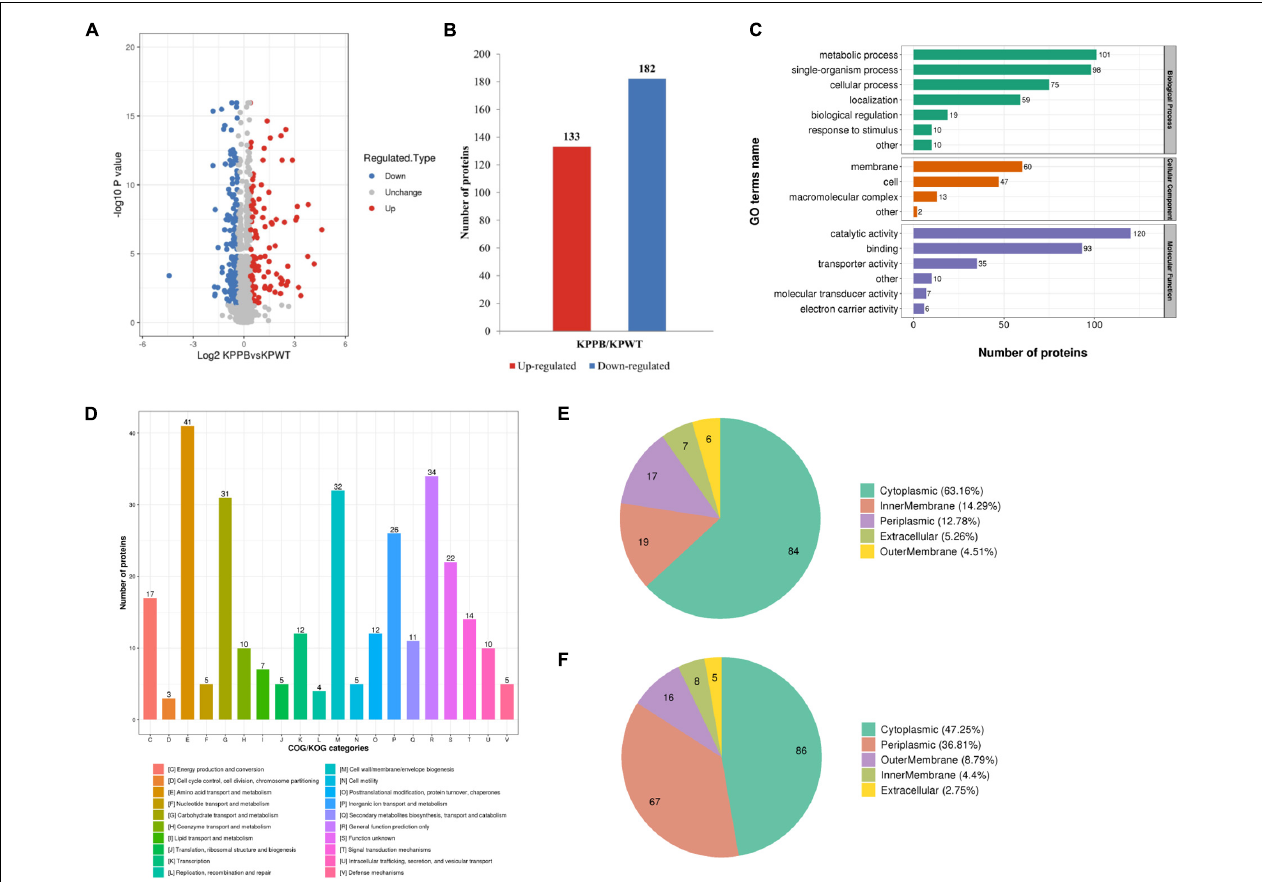
FIGURE 2 | Quantitative proteomics analysis of polymyxin B (PB) resistant and susceptible Klebsiella pneumoniae . (A) Volcano plot of the differentially expressed proteins (DEPs). The x -axis represents expression changes and the y axis represents the statistical significance between the two groups. (B) Numbers of increased and decreased DEPs. (C) Number of DEPs in the biological process, cellular component, and molecular function categories revealed by GO annotation. (D) Functional classification of the DEPs in COG categories. Subcellular localization of upregulated (E) and downregulated (F) DEPs in PB-resistant K. pneumoniae compared to –susceptible K. pneumoniae